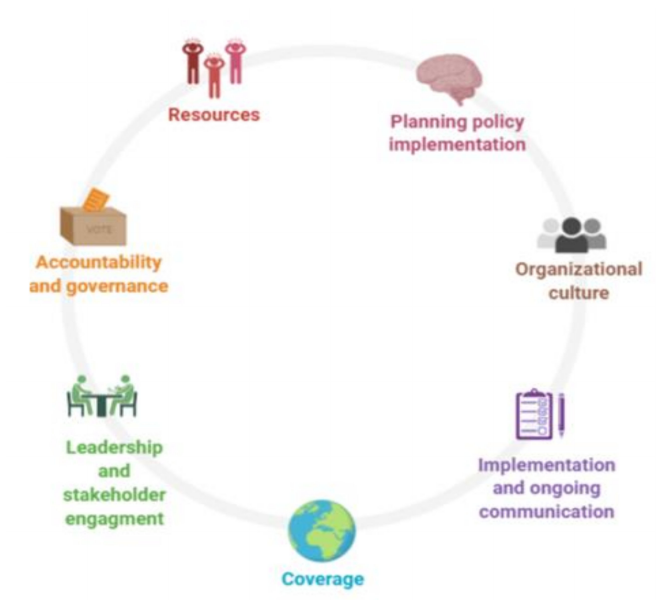
Figure 2. Seven critical areas for action in the implementation of the 1000 days plus activities in